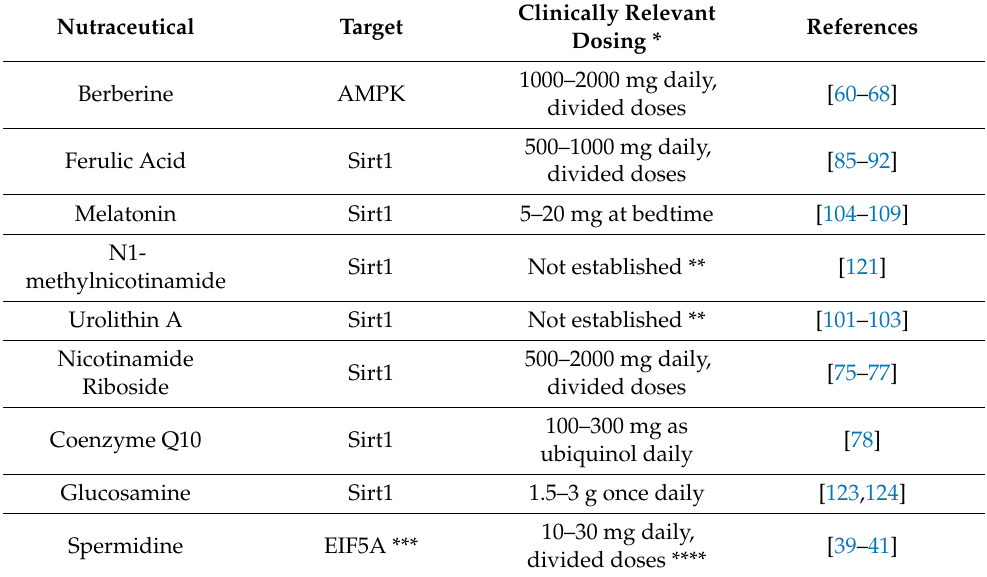
Table 1. Nutraceuticals with potential for activation of